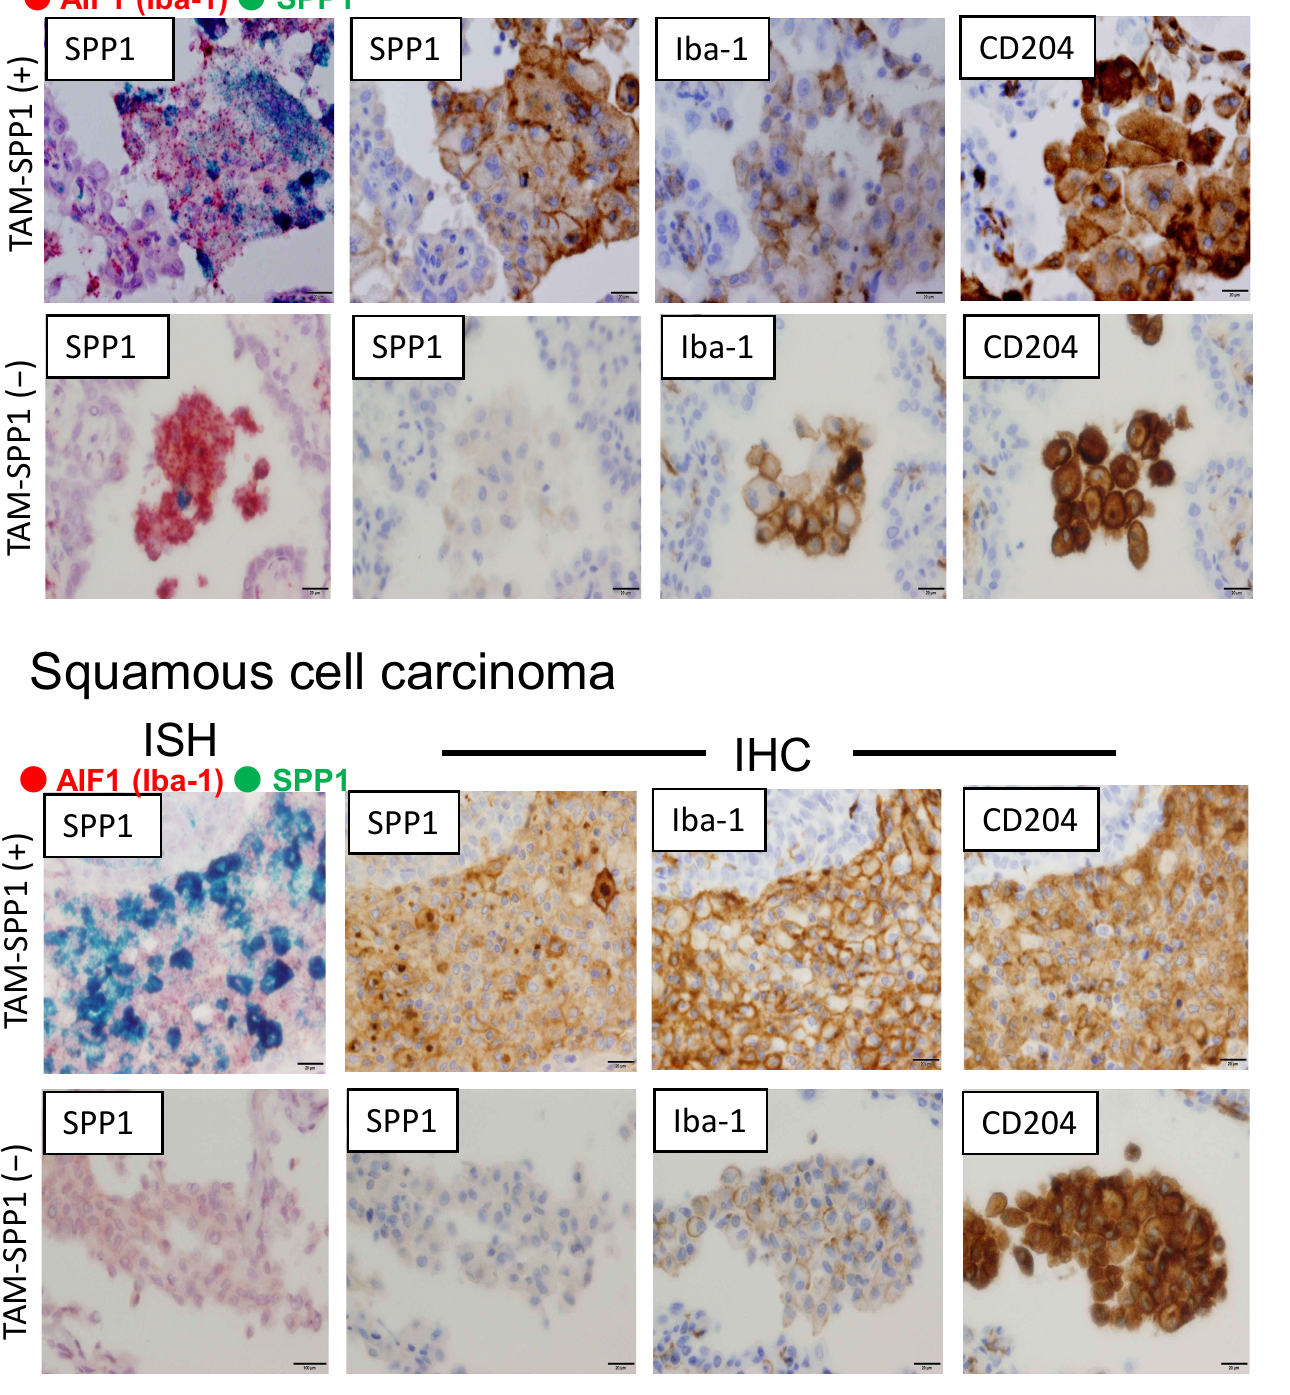
Figure 1. Dual-ISH of SPP1 and Iba-1 (green: SPP1; red: Iba-1) and IHC of SPP1 and other macrophage markers (Iba-1 and CD204) using serial sections of adenocarcinoma and